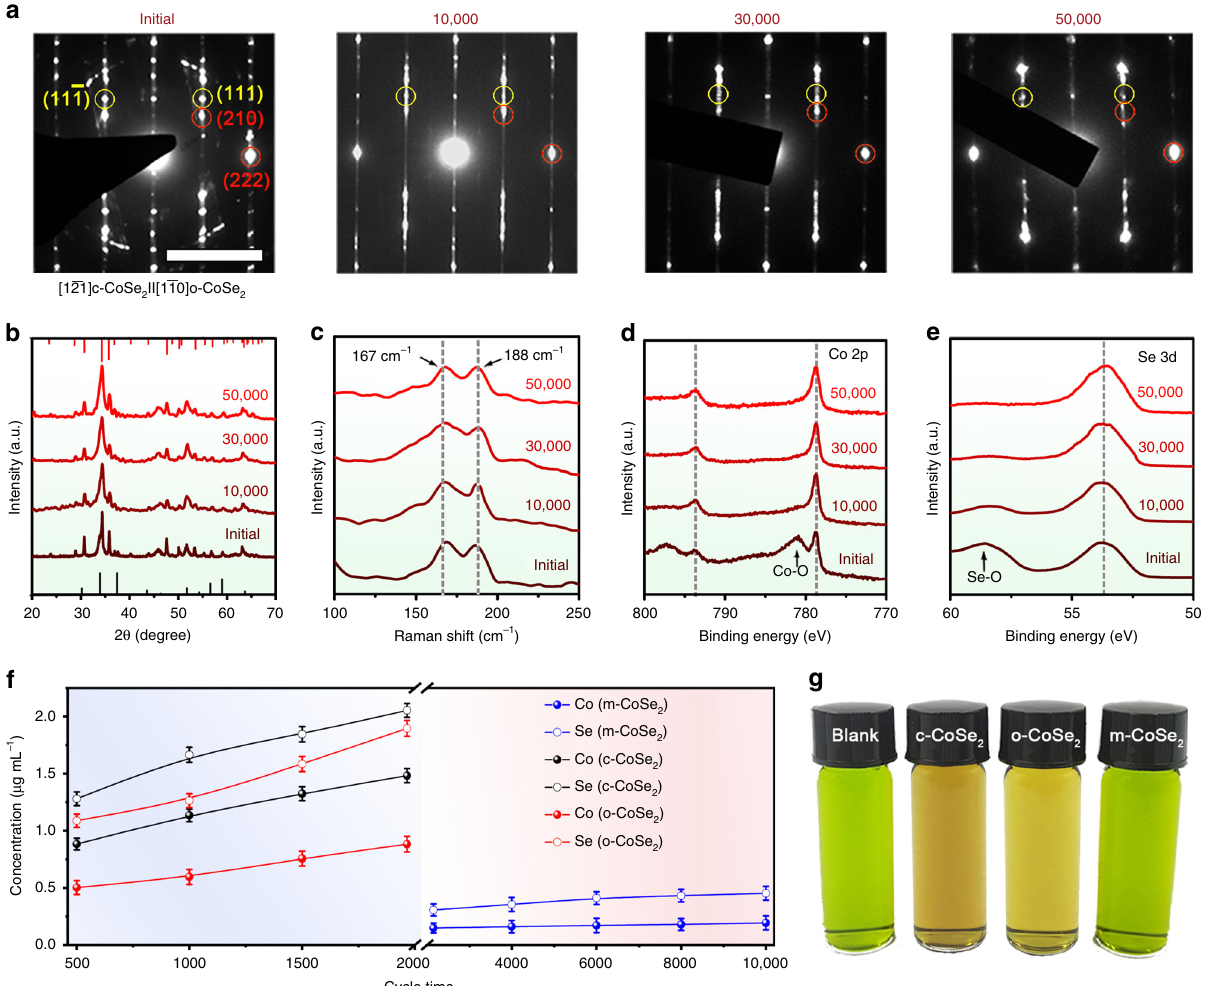
Fig. 4 Structural stability of m-CoSe 2 . a – e , SAED patterns ( a ), XRD patterns ( b ), Raman spectra ( c ), Co 2 p XPS spectra ( d ), and Se 3 d XPS spectra ( e ) of the m-CoSe 2 catalyst before and after different potential cycles. Scale bar in a , 5 1/nm. f ICP-AES measurements compare the Co and Se dissolved into acidic electrolyte after different potential cycles for m-, c-, and o-CoSe 2 catalysts. g Colorimetric comparison of the cycled electrolytes added in sodium acetate and nitroso-R salt solution. No color change was seen for m-CoSe 2 , indicating its marked structural stability in acidic electrolyte. Nitroso-R salt was used as the color indicator. The freshly-made c - and o-CoSe 2 catalysts were treated in pure deionized water at 200 °C for 12 h before cycling to remove any potential unstable or amorphous